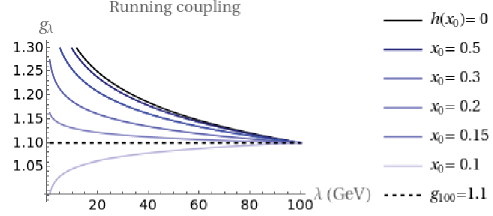
Figure 3. Running coupling for di ff erent values of x 0 , the black line ( h ( x 0 ) = 0) represents the result obtained from the renormal- ization group equations in Euclidean space. The function exhibits asymptotic freedom from x 0 = 0 . 5 down to values of x 0 ≈ 0 . 13.